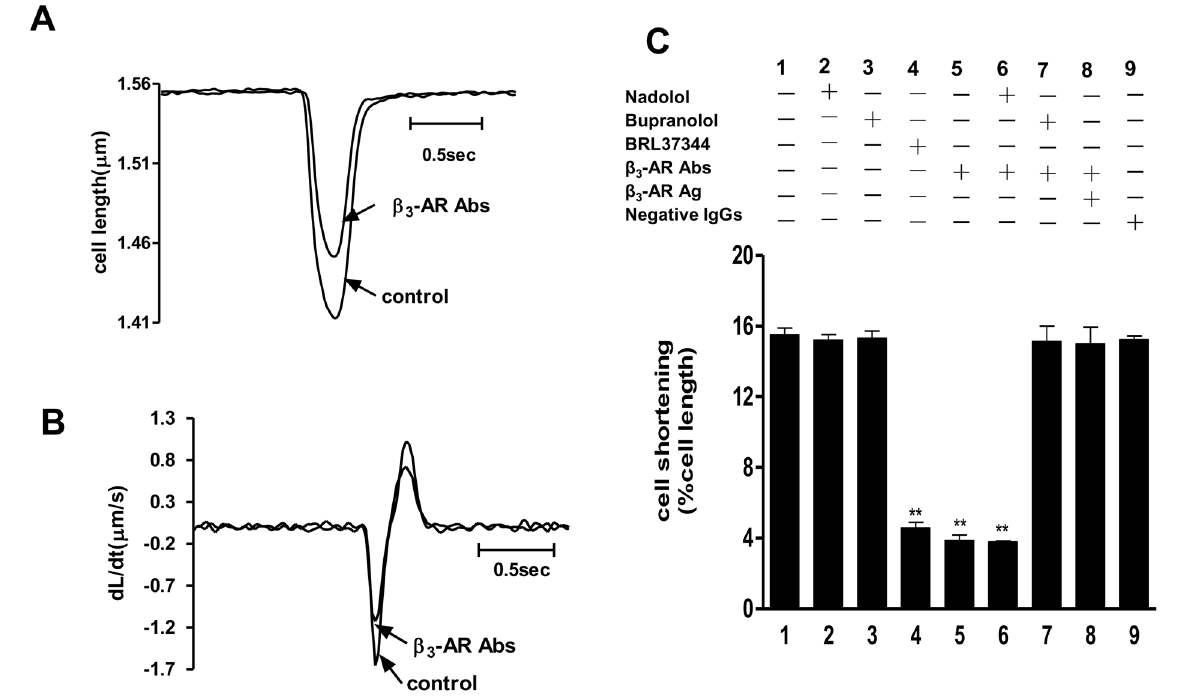
Figure 6. Negative inotropic effect of β -AR Abs on isolated adult rat cardiomyocytes. A and B. Representative profiles of 3 cell length and dL/dt. C. Negative inotropic agonist-like activities of β -AR Abs (0.1 µmol/L, n=10) and the effects of nadolol, 3 bupranolol, and β -AR antigen upon β -AR Abs-induced activities in isolated adult rat cardiomyocytes. ( ** P < 0.01 vs . control, 3 3